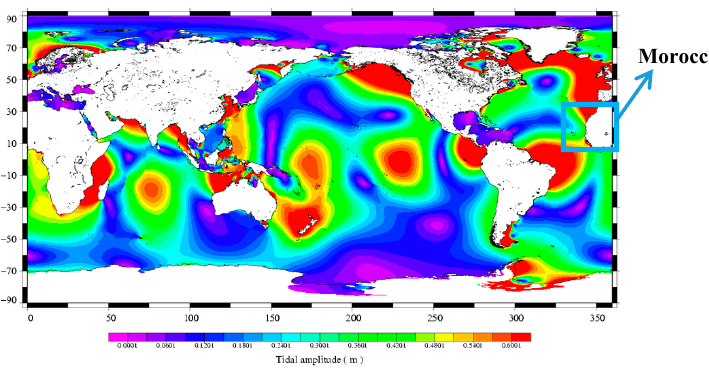
Figure 1. Tidal range resources worldwide. Source: